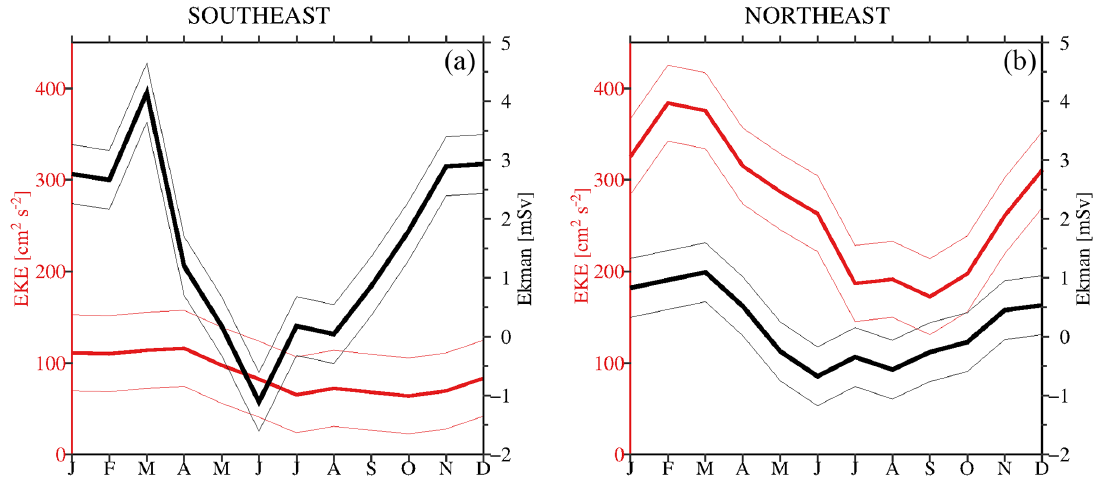
Figure 8. (a) The seasonal cycle of EKE (red line) and Ekman transport (black line) (1990–2009) in the southeast (see the white box and section in Fig. 7). The thin lines show the associated standard deviation. (b) Same but for the northeast.